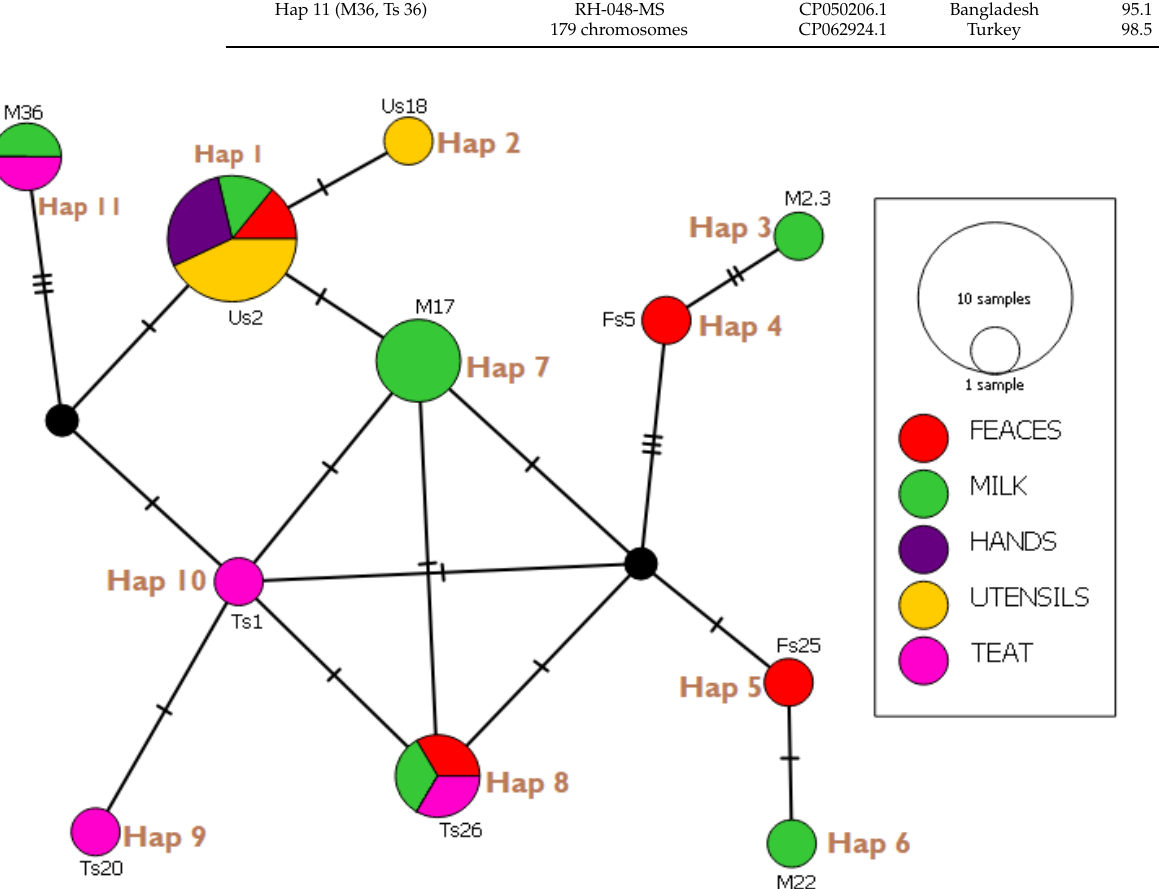
Figure 2. E. coli uidA (~147 bp) haplotype network of sequences from present study. Circle size indicate the frequency of haplotype in the dataset and the strokes refer to mutational steps. The overall indices of the genetic population studies of 22 E. coli samples isolated from milk and its related sources showed a haplotype diversity (Hd) of 0.877, nucleotide diversity (X) of 0.0360163, and variance of Hd as 0.00237. Haplotype 1 had the highest haplotype frequency of 31.8%, whereas haplotypes 2, 3, 4, 5, 6, 7, 8, 9 and 10 shared the least, with a haplotype frequency of